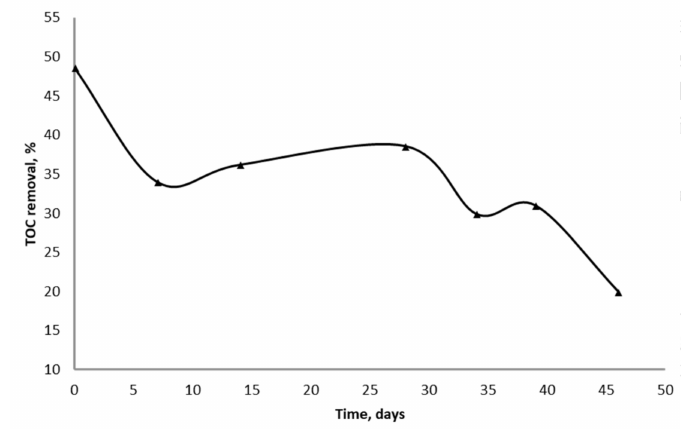
Figure 3. The removal of TOC from wastewater during continuous process in the column reactors with used iron